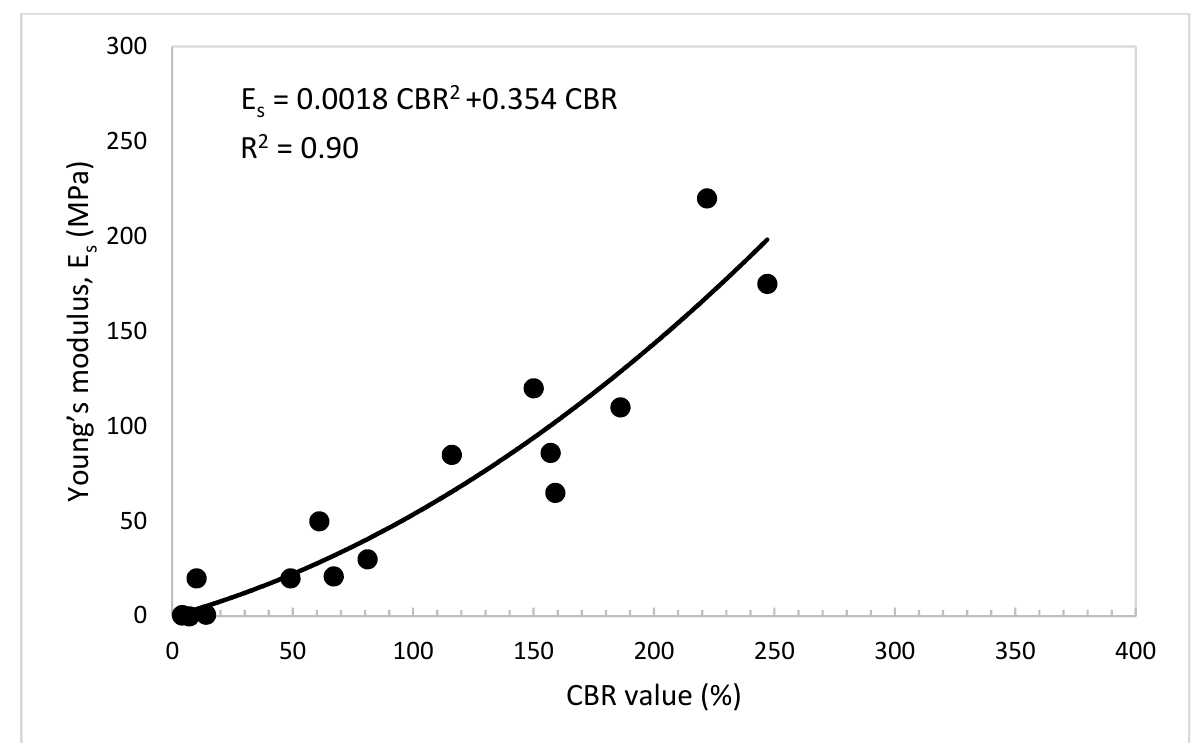
Figure 17. Young’s modulus, E s vs. CBR value of the treated dune sand.